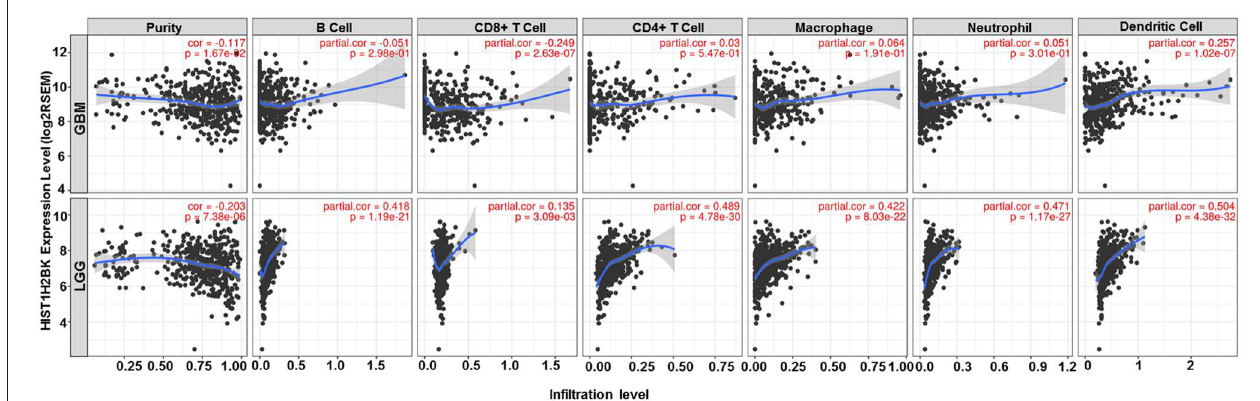
FIGURE 5 | Correlation between the expression of HIST1H2BK and immune infiltration of glioma cells. GBM, glioblastoma; LGG, low grade glioma.